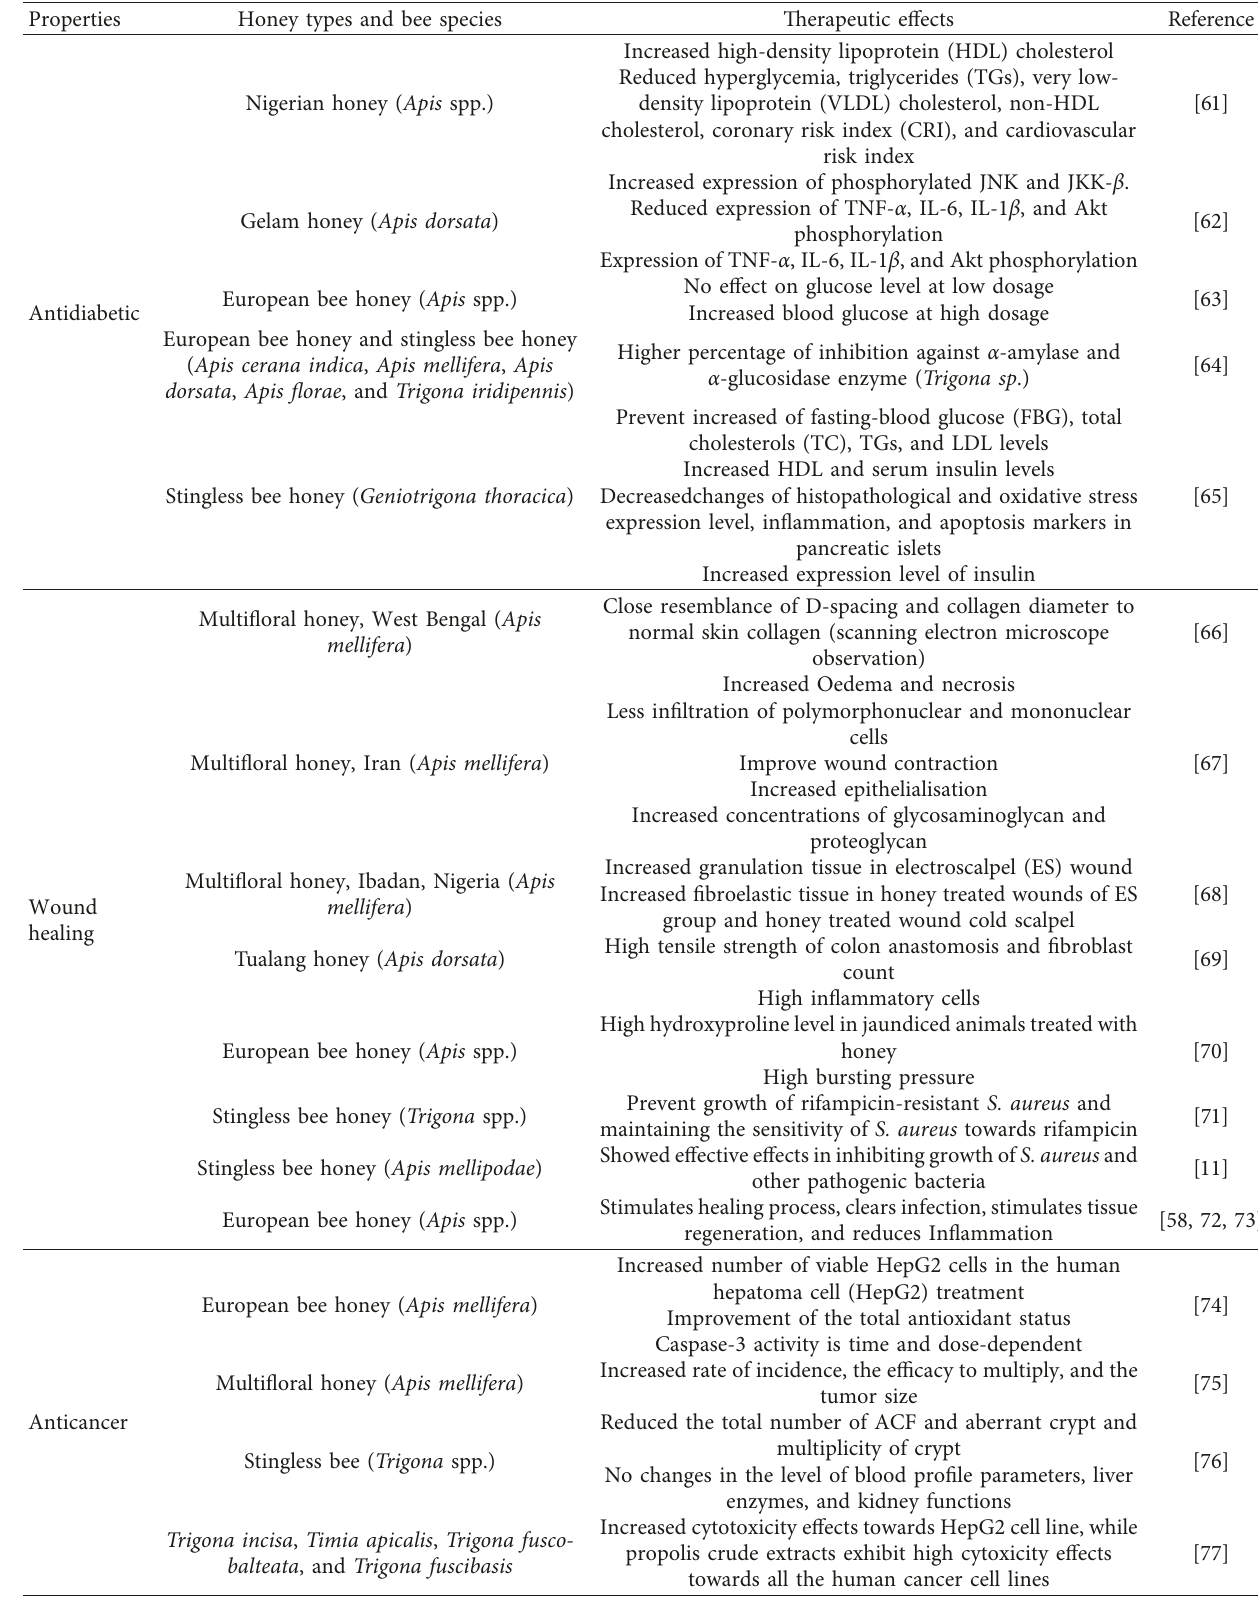
Table 3: Summary of therapeutic properties of European bee honey and stingless bee honey from previous studies.